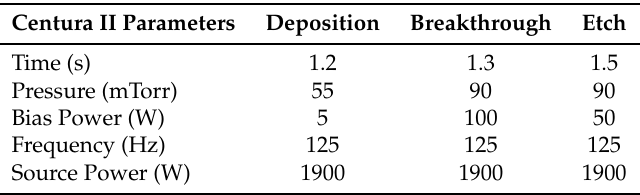
Table A2. Overview of the etch details in Centura II (DPS &